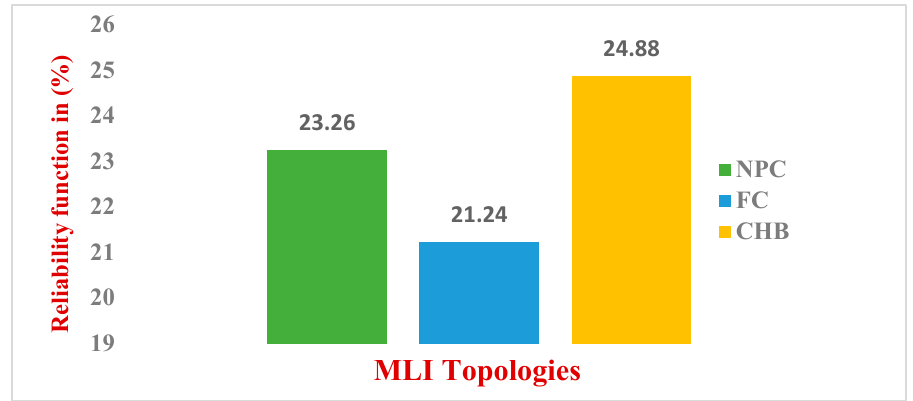
Figure 26. The e ff ect of MLI topologies on reliability function. 4. The E ff ects of PV Array Size on the Durability and Reliability of PV Inverters